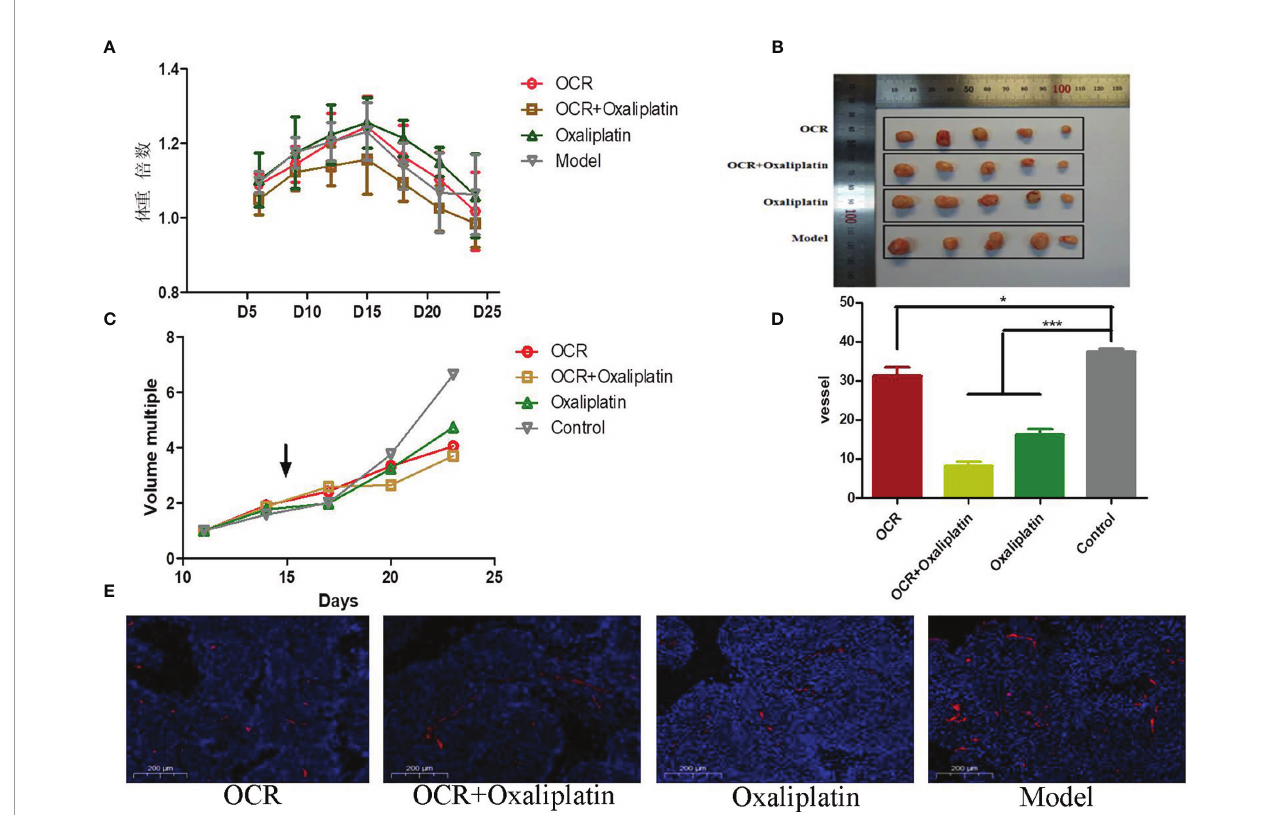
FIGURE 5 | The inhibitory effects of essential oil from Curcumae rhizoma (CR) (OCR) on subcutaneously transplanted colon cancer tumours. (A) Changes in mice body weight in different groups. (B, C) Tumour size in different groups. (D, E) CD31 marker expression in tumours in different groups. (n = 5, mean ± standard deviation (SD), ***P < 0.001, *P < 0.05 compared with the control